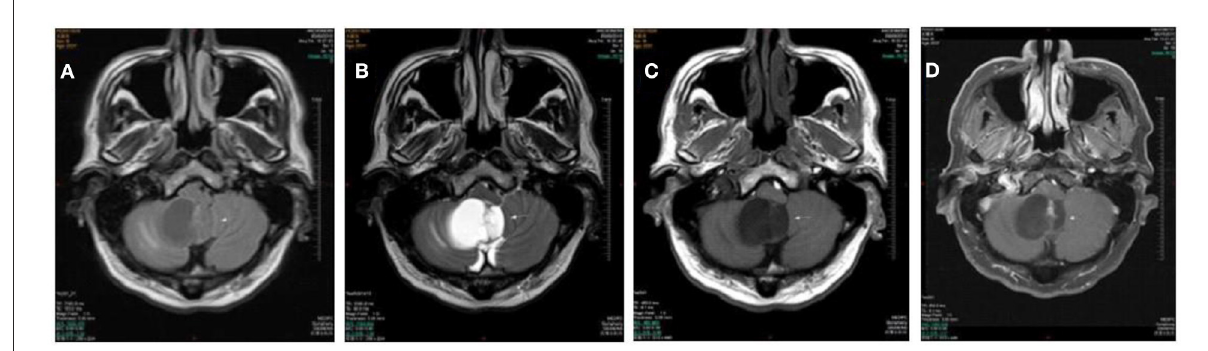
FIGURE2 Cases 5: cerebellar hemangioblastomas. Axial T1WI (A) , axial T2WI (B) , and axial FLAIR (C) show a cyst mass in the cerebellar hemisphere and vermis with the marked hypointense signal on T1WI, the hyperintense signal on axial T2WI, and iso- and hypointense on FLAIR. The lesion shows septum and nodule enhancement on postcontrast axial T1WI with fat saturation (D) .